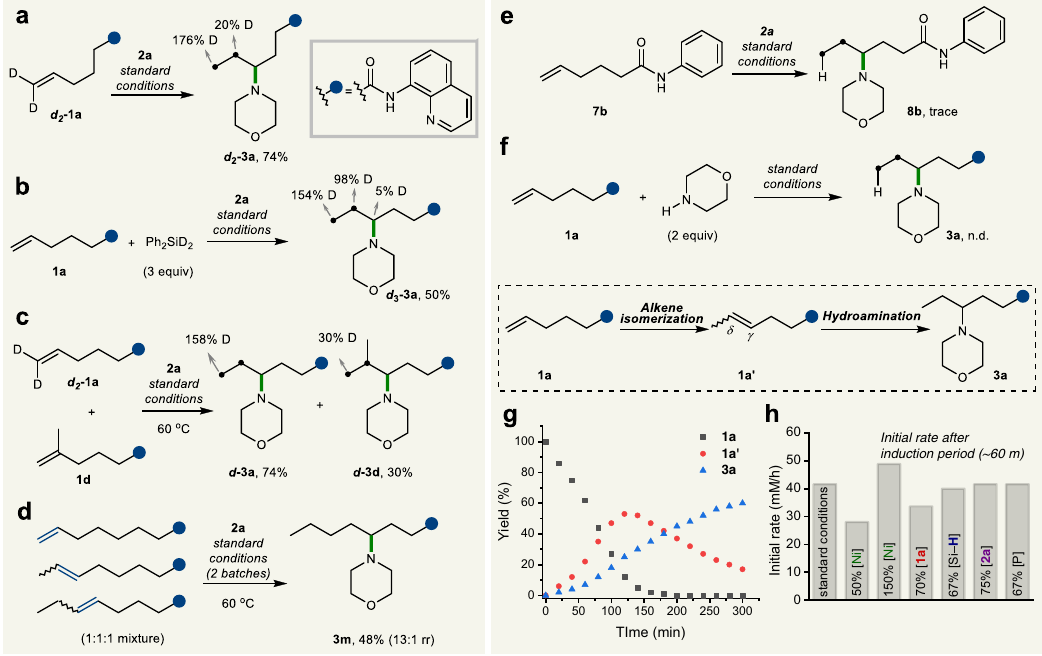
Fig. 4 Deuterium labeling studies and control experiments. a Deuterium migration experiment. b Deuteration with Ph 2 SiD 2 . c Crossover experiment. d Regioconvergent experiment. e Monodentate directing group. f Free amine as an coupling partner. g Time pro fi ling experiment. h Summary of different- excess